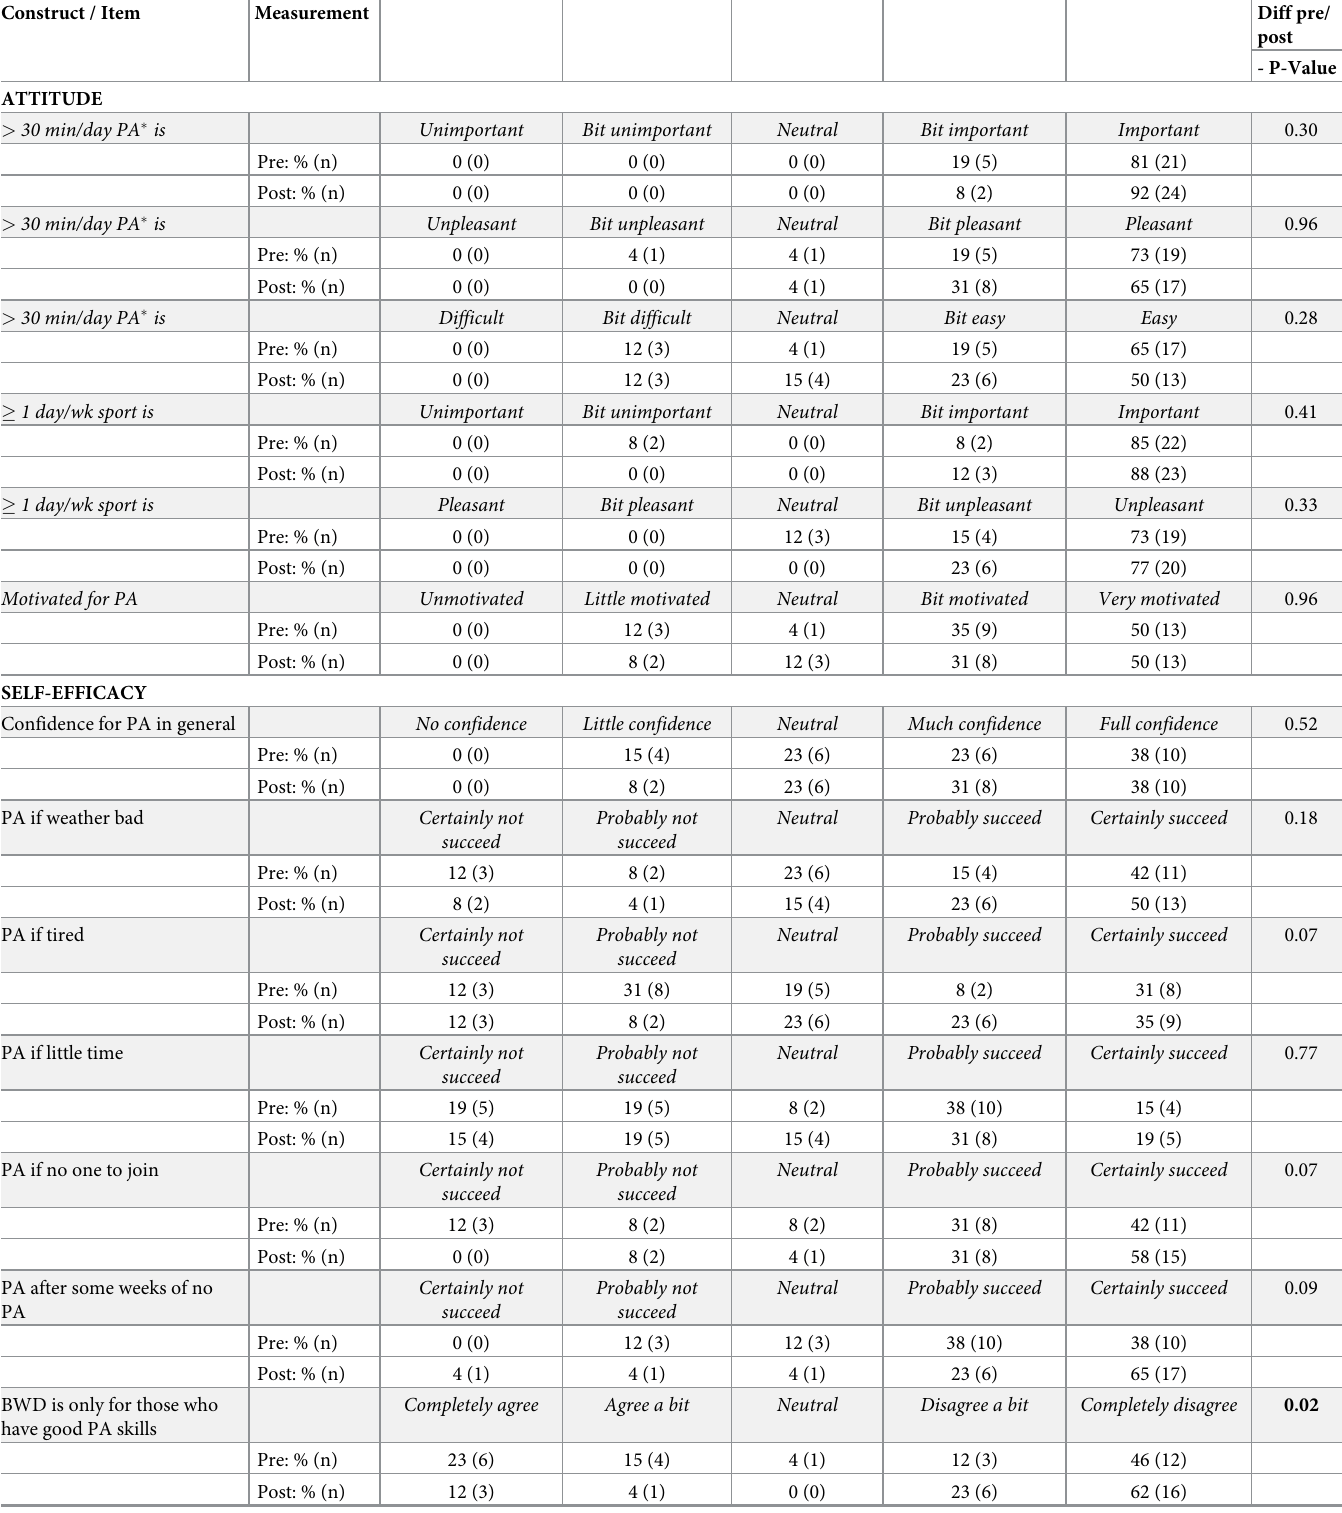
Table 5. The effect of Bollywood Dance Fitness on physical activity behavioral social cognitive determinants. Construct /